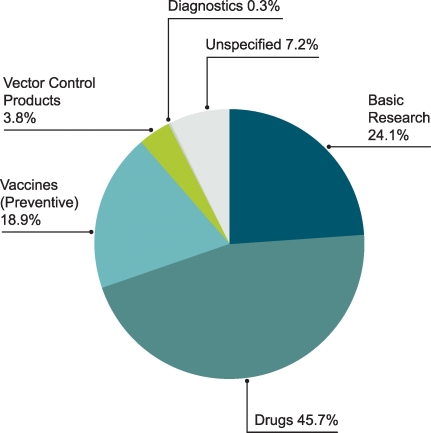
Malaria R&D Funding in 2007